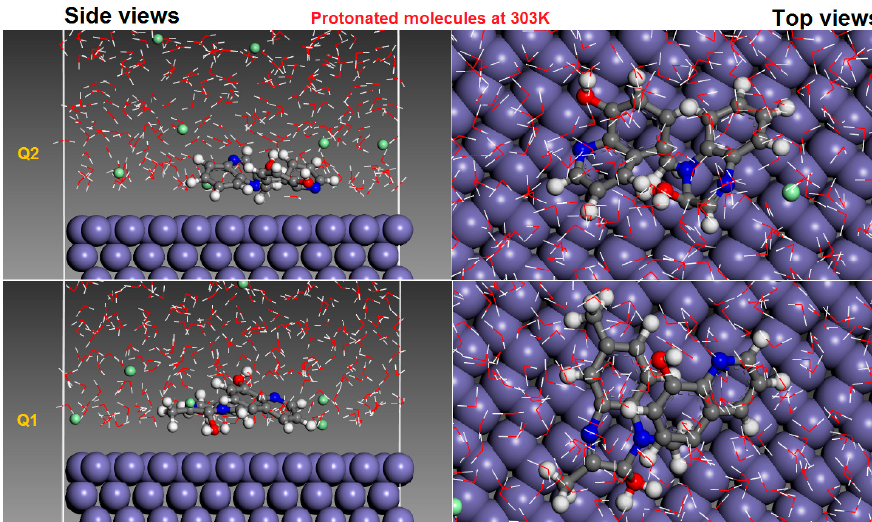
Figure 9. Side and top views of the most appropriate configuration for the adsorption of Q1 and Q2 inhibitors in their protonated forms on Fe (110) surface using MD simulations in the aqueous solution at 303 K.